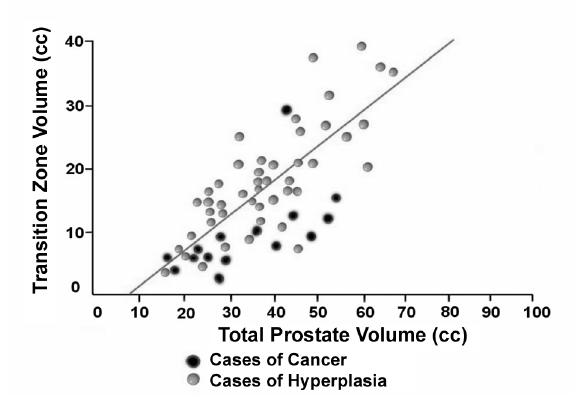
Figure 1 – Scatter graph with regression straight line showing the correlation between total prostate volume (X axis) and tran- sition zone volume (Y